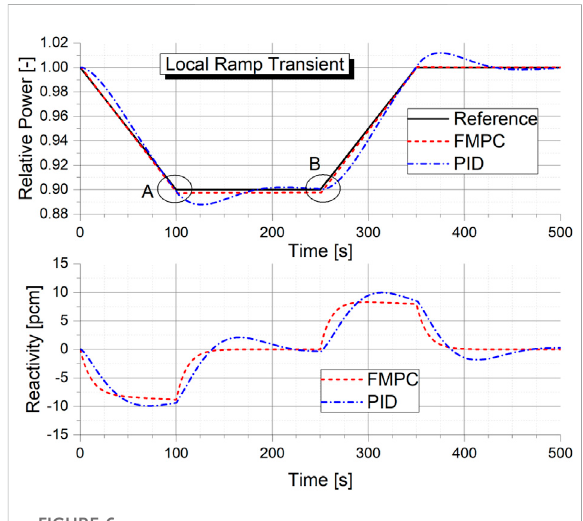
Simulation results for the working condition: local ramp